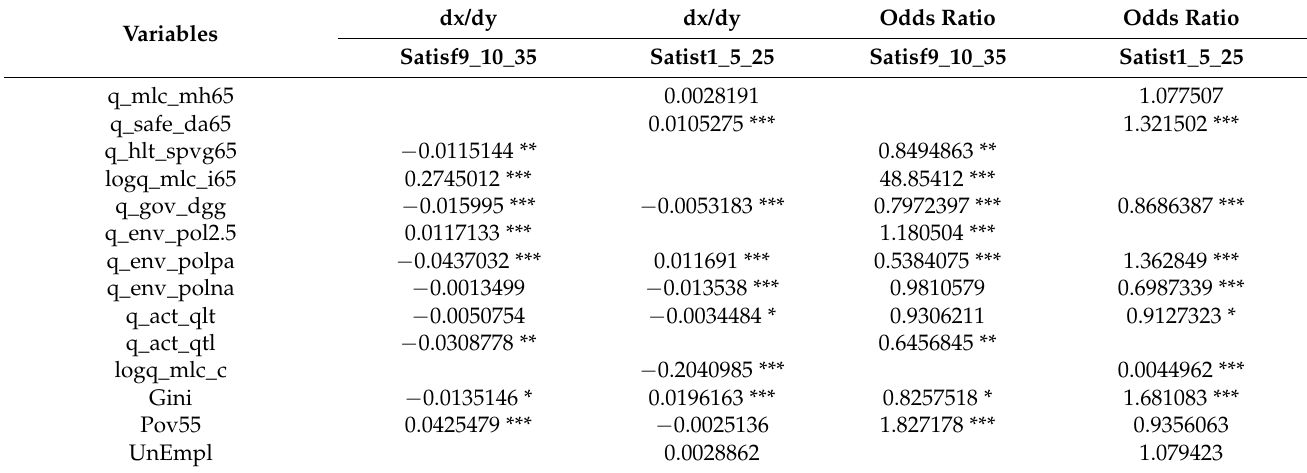
Table 2. Margins y Odds